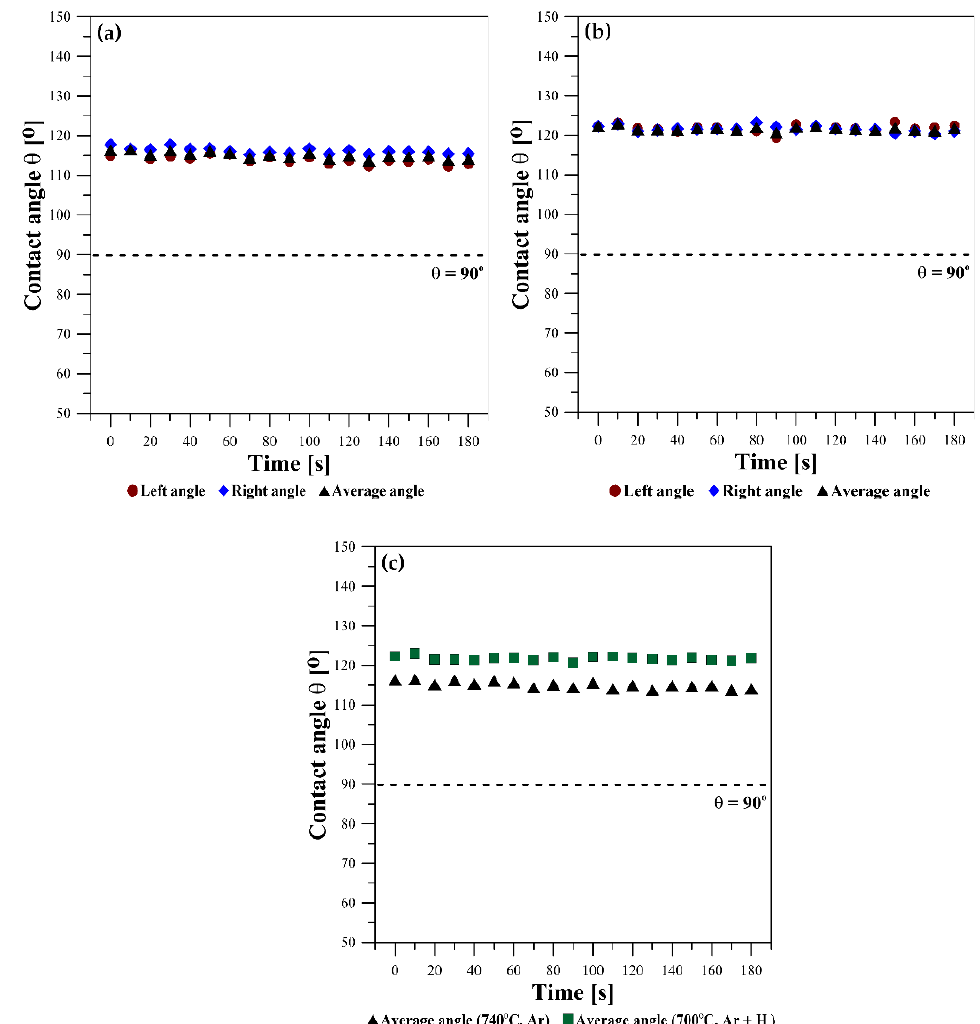
Figure 7. Wetting kinetics of liquid Mg on the tungsten substrate registered for 180 s under different atmospheres: ( a ) Ar at T = 740 °C; ( b ) Ar + 5 wt.% H 2 at T = 700 °C; ( c ) comparison of θ av between Mg/W couples received under the flowing Ar at T = 740 °C and Ar + 5 wt.% H 2 at T = 700 °C, respec- tively.